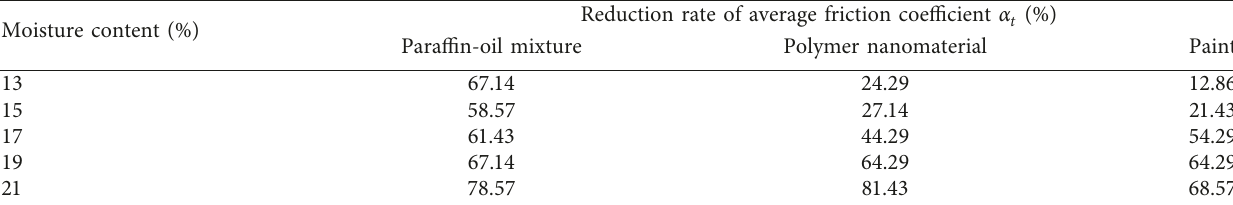
Table 6: Reduction rate of average friction coefficient.